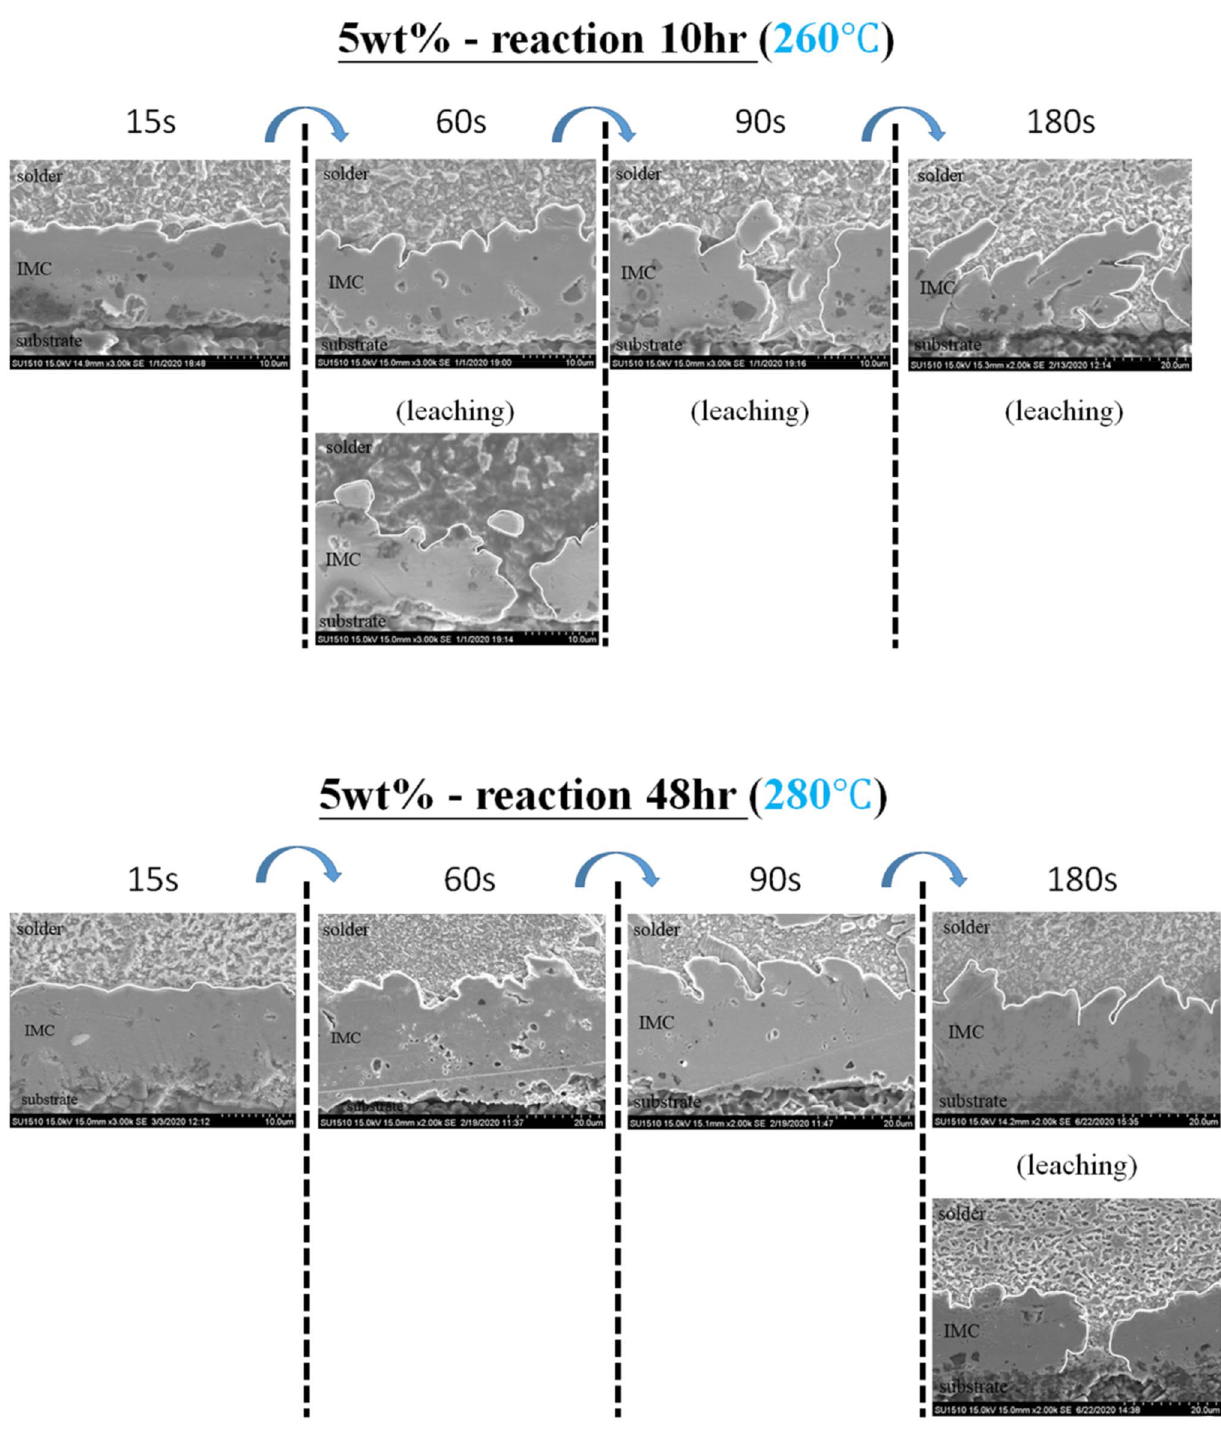
Fig. 6 Cross-sectional SEM images of interfaces after soldering at 260 °C and 280 °C for various times for silver pastes with 5 wt% TEOS at reaction times of 10 and 48